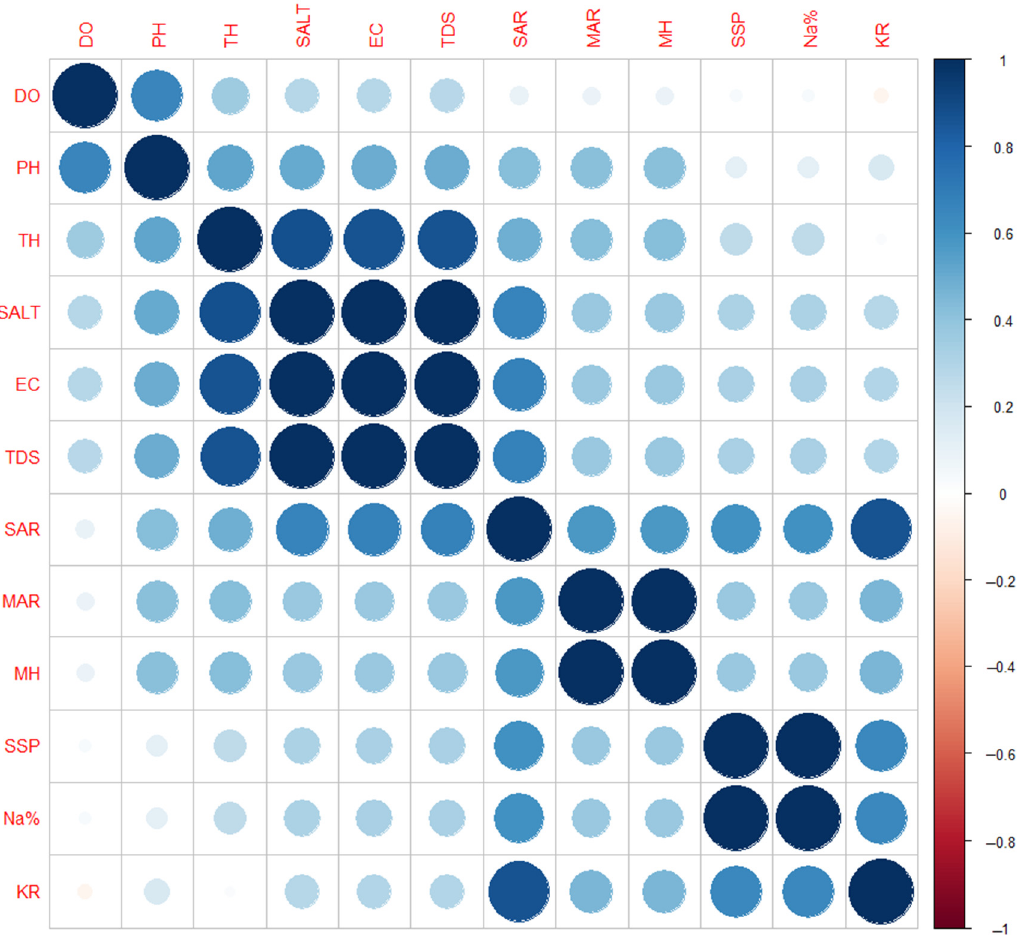
Figure 7. Correlation matrix between physicochemical parameters and indices of irrigation water, Pearson correlation test values are presented as correlation coefficients (above diagonals and shown by color and intensity of shading in pie charts and squares) and p -values (below diagonal).